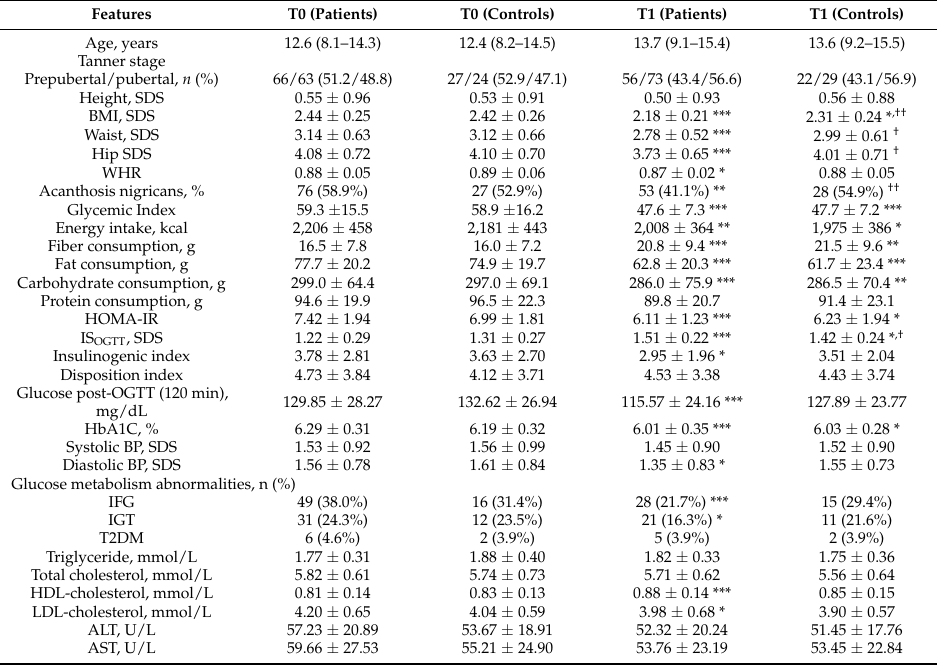
Table 1. Anthropometric, dietary, clinical and biochemical features before and after metformin treatment and in control group.